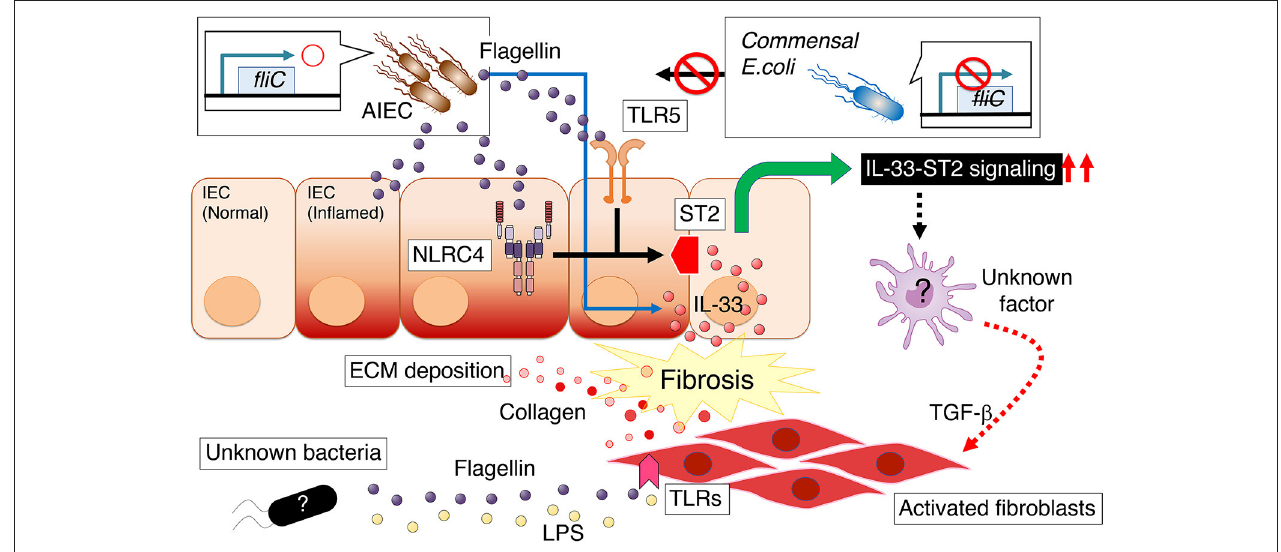
FIGURE 2 | Persistent intestinal colonization of AIEC strain LF82 potentiates the development of intestinal fibrosis, a common and potentially severe complication of intestinal colitis ( 66). Flagellin produced by AIEC promotes the expression of interleukin 1 receptor–like 1 (IL1RL1, also known as ST2) in intestinal epithelial cells (IECs), which depends on flagellin ligands TLR5 and NLRC4 on IECs. ST2 expression augments IL-33 signaling, thereby promoting intestinal fibrosis. Conversely, there is a mechanism by which intestinal myofibroblasts directly respond to flagellin with enhanced fibronectin or collagen production in a MyD88-dependent manner ( 65). AIEC, adherent–invasive Escherichia coli ; ECM, extracellular matrix; LPS, lipopolysaccharide; ST2, interleukin 1 receptor–like 1 (IL1RL1, also known as